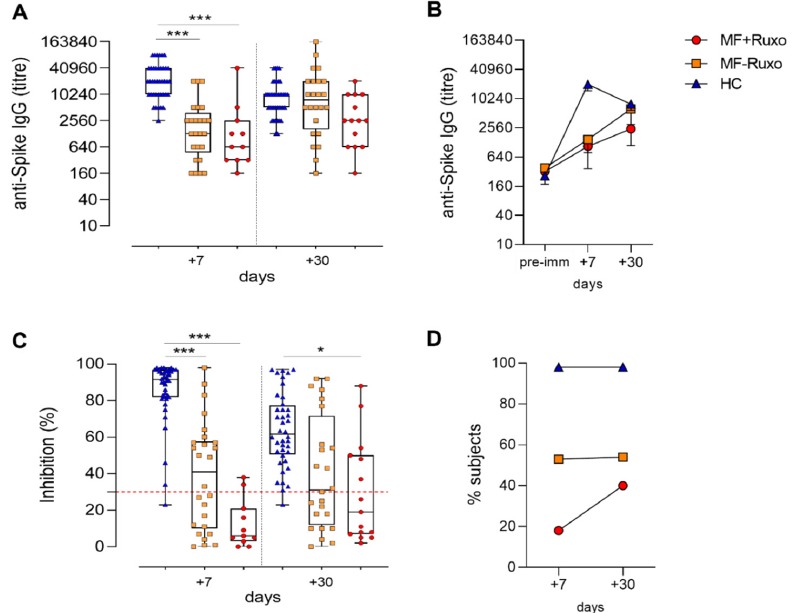
Figure 2. Humoral immune response against SARS-CoV-2 in MF patients post-second dose of mRNA vaccination. ( A ) IgG titers specific for the spike protein assessed by ELISA in plasma of patients with myelofibrosis (MF) patients, treated or not with ruxolitinib (MF + Ruxo or MF-Ruxo), and healthy controls (HC), at different time points after the second vaccine dose. Antibody end point titers were expressed as the reciprocal of the sample dilution, reporting double the background OD value. ( B ) Time course of spike-specific IgG in plasma collected at the baseline (pre-immune) and 7 and 30 days from the second dose of mRNA SARS-CoV-2 vaccine. (C ) ACE2/RBD binding inhibition activity tested in plasma using a SARS-CoV-2 surrogate virus neutralization test. Results are expressed as ACE2/RBD binding inhibition percentage with box and whiskers diagram showing all subject values. Inhibition values >30% are regarded as positive results according to the manufacturer indication. ( D) Percentage of subjects developing ACE2/RBD inhibition positive values (>30%) in the different groups. Kruskal–Wallis test, followed by Dunn’s post-test for multiple comparisons, was used for assessing statistical differences between groups. * p ≤ 0.05; *** p ≤ 0.001. Healthy control (HC), myelofibrosis (MF), ruxolitinib (Ruxo). Table 2 Number and percentage (in bracket) of patients with seroconversion and binding inhibition activity detected within MF patients (MF + Ruxo and MF-Ruxo) and HC subjects.